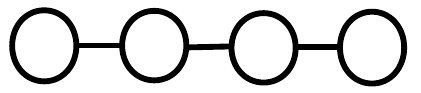
Figure 2 . The diagram depicting the matter contents of the linear theory with n =